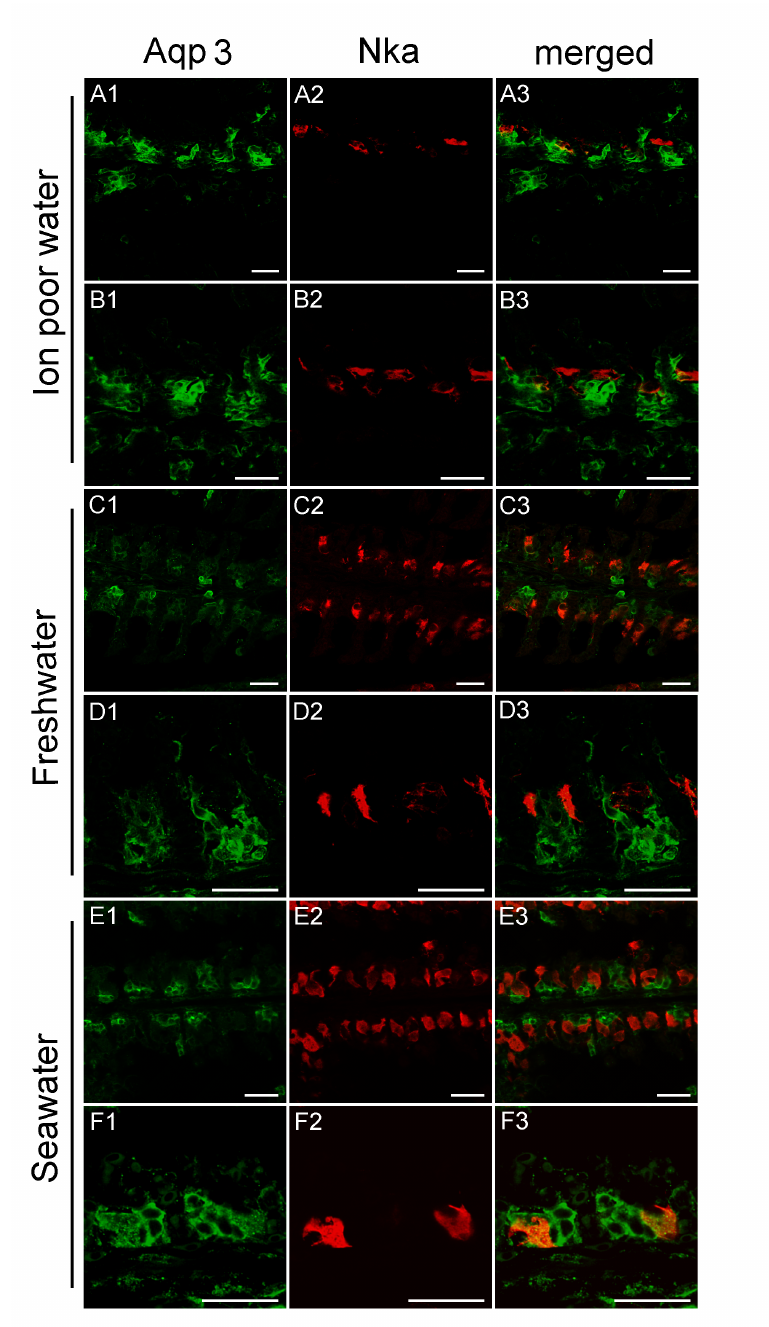
Figure 6. Representative confocal images of sagittal sections of medaka gills showing immunoreactivity against medaka AQP3 (green), the Na + ,K + -ATPase alpha subunit (red), and merged. Rows A and B are from IPW fish, C and D are from FW fish, and E and F are from SW fish. Scale bar = 20 µ m. For orientation see Figure